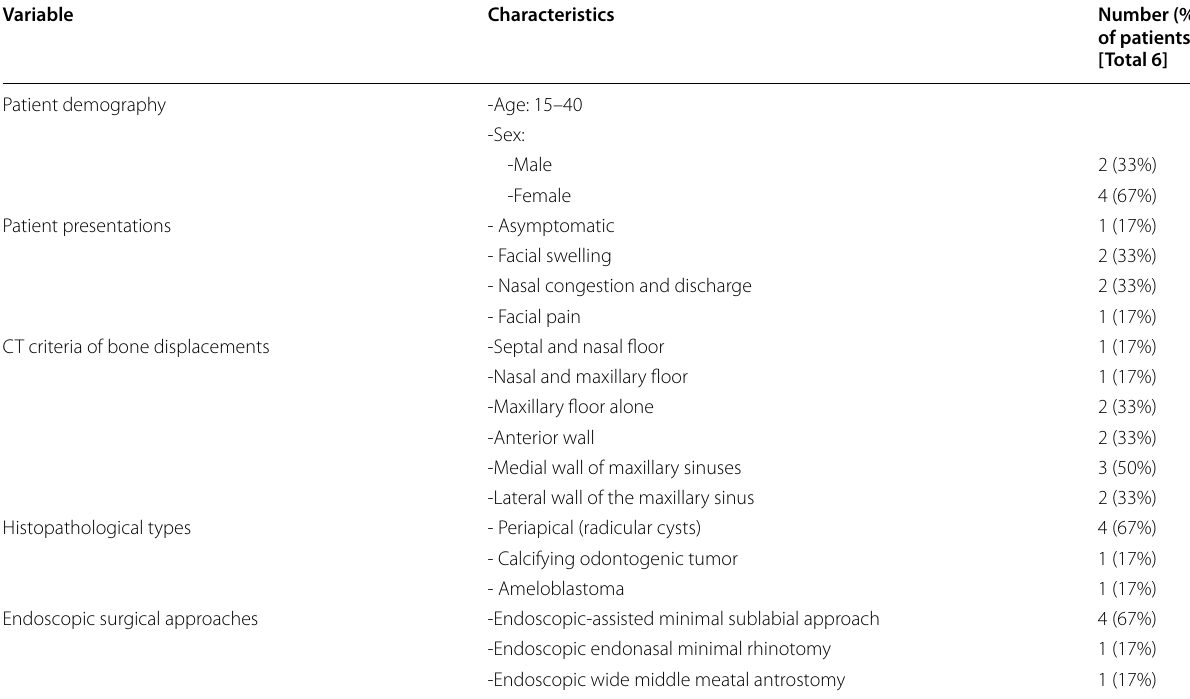
Table 1 Demographic, clinical, CT characteristics, histopathological types of the cysts, and endoscopic surgical approaches